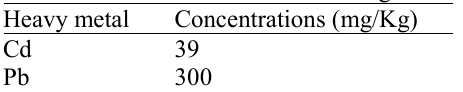
Table 4. Recommended maximum limits of EPA for cadmium and lead in wastewater sludge Heavy